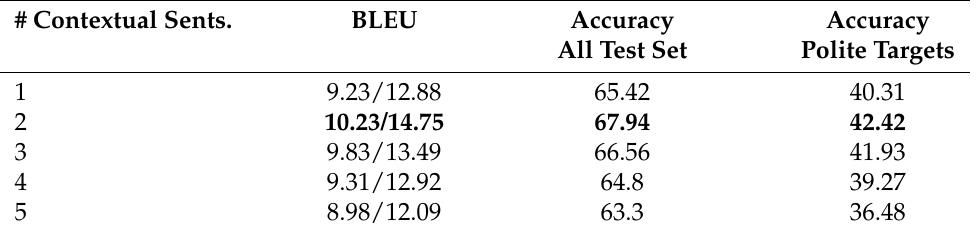
Table 4. English-Korean BLEU scores (normal/tokenized) and accuracy (%) by the number of contex- tual sentences on HCE # Contextual